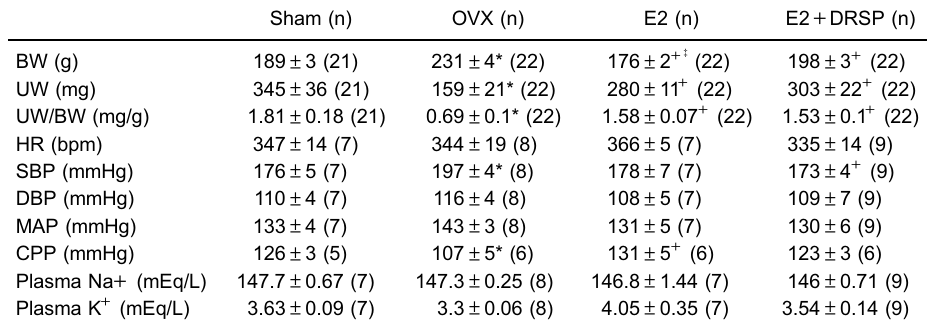
Table 1. Body weight, estrogenic status, hemodynamic parameters, and plasma electrolyte